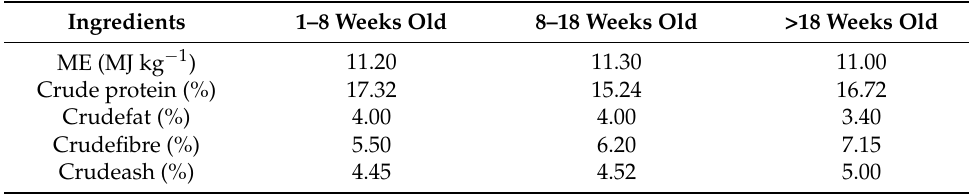
Table 1. Basic chemical composition of feed